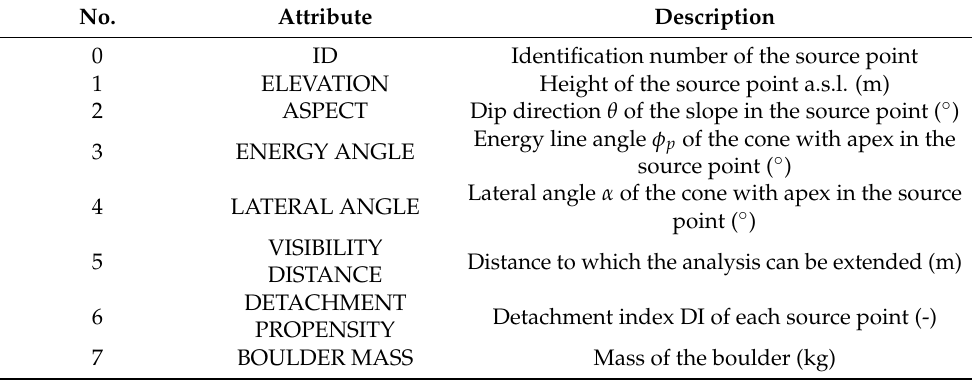
Table 1. List of attributes needed to perform a propagation analysis using the QPROTO plugin.